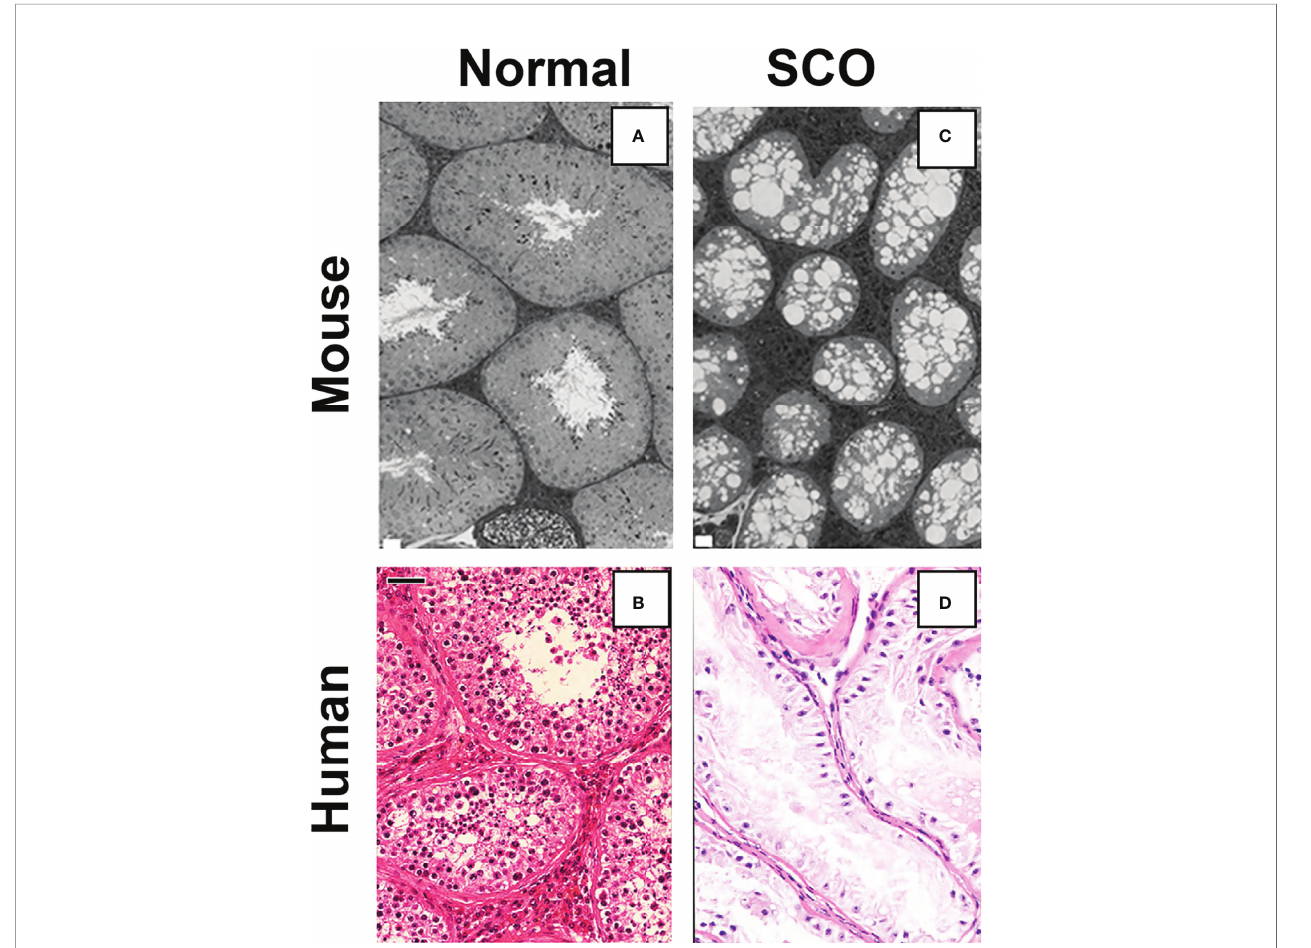
FIGURE 3 | A comparison of the testicular histology of control (A) and treated Ret(V805A) mice (C) with the histology of normal (B) and SCO (D) human testes. No spermatogenic cells are evident in the image of testes from treated mouse testis or the image of a human SCO testis. Ret(V805A) mice were injected for 30 days with vehicle (A) or with 1NAPP1 (C) for 30 days and testes collected 35 days later. Mouse testes were fi xed with glutaraldehyde, embedded in epon and 1-micron thick sections stained with Toluidine blue. Sections of human testes were prepared from biopsies collected as part of standard clinical care. Five-micron thick sections were stained with hematoxylin and eosin and all patient identi fi ers were removed before sections became available for microscopic analysis. The white bars on panels (A) and (C) are equal to 20 microns on the original section. The black bar on panel (B) is equal to 40 microns. Micrographs are from: (5,